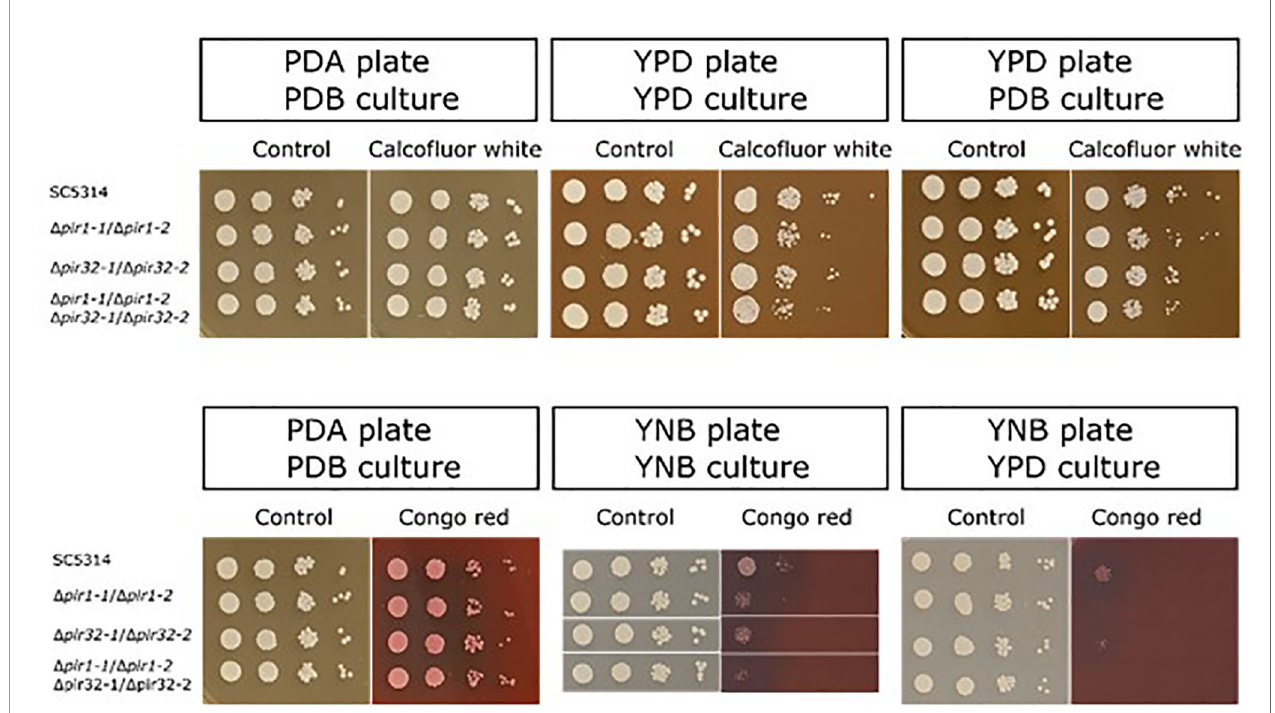
FIGURE 3 | (Top panel) Growth of the C. albicans D pir mutant strains on agar plates containing calco fl uor white. Starter cultures were grown in either YPD or PDB. Cells were washed in DPBS, counted, and serially diluted. Five m l of each dilution (10 6 to 10 3 cells/ml, left to right in each panel) were spotted onto a YPD or PDA plate containing 150 m g/ml calco fl uor white. Plates were incubated at 37°C for 48 h and photographed. Cells were grown without calco fl uor white as a control (left panel for each pair of images). Growth inhibition by calco fl uor white was dependent on the combination of growth medium used for the starter culture and for the agar plate. (Lower panel) Growth of the D pir mutant strains on agar plates containing Congo red. Starter cultures were grown in PDB, YNB, or YPD. Cells were washed in DPBS, counted, and serially diluted. Five m l of each dilution (10 6 to 10 3 cells/ml, left to right in each panel) were spotted onto a PDA or YNB plate containing either 50 m g/ml (left panel) or 30 m g/ml (middle and right panels) Congo red. Plates were incubated at 37°C for 48 h and photographed. Cells were grown without Congo red as a control (left panel for each pair of images). Growth inhibition by Congo red was dependent on the culture medium and observed only for cells grown on YNB plates. Results indicating Congo red sensitivity among the mutant strains were not obtained in a repeatable manner. In each panel, control and experimental plates pictured were from the same assay